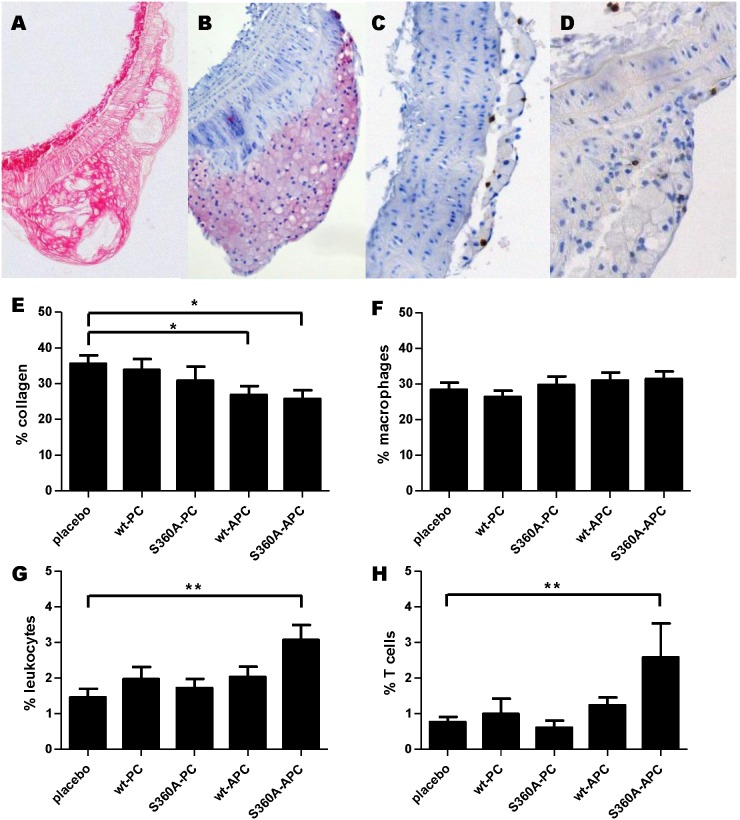
Only S360A-APC treatment influences plaque phenotype.Images of plaques stained for collagen (A), macrophages (B), leukocytes (C), and T cells (D). E) After sirius red staining, the percentage of collagen was determined by dividing the area of collagen by the total plaque area. F) After Mac-3 staining, the percentage of macrophages as a percentage of the total number of cells per plaque was calculated. G) After CD45 staining, the percentage of leukocytes as a percentage of the total number of cells per plaque was calculated. H) After CD3 staining, the percentage of T cells of the total number of cells per plaque was calculated. All graphs show mean +/− SEM, statistical significance was tested using one-way analysis of variance with Dunnett post hoc test, *P<0.05, **P<0.01.